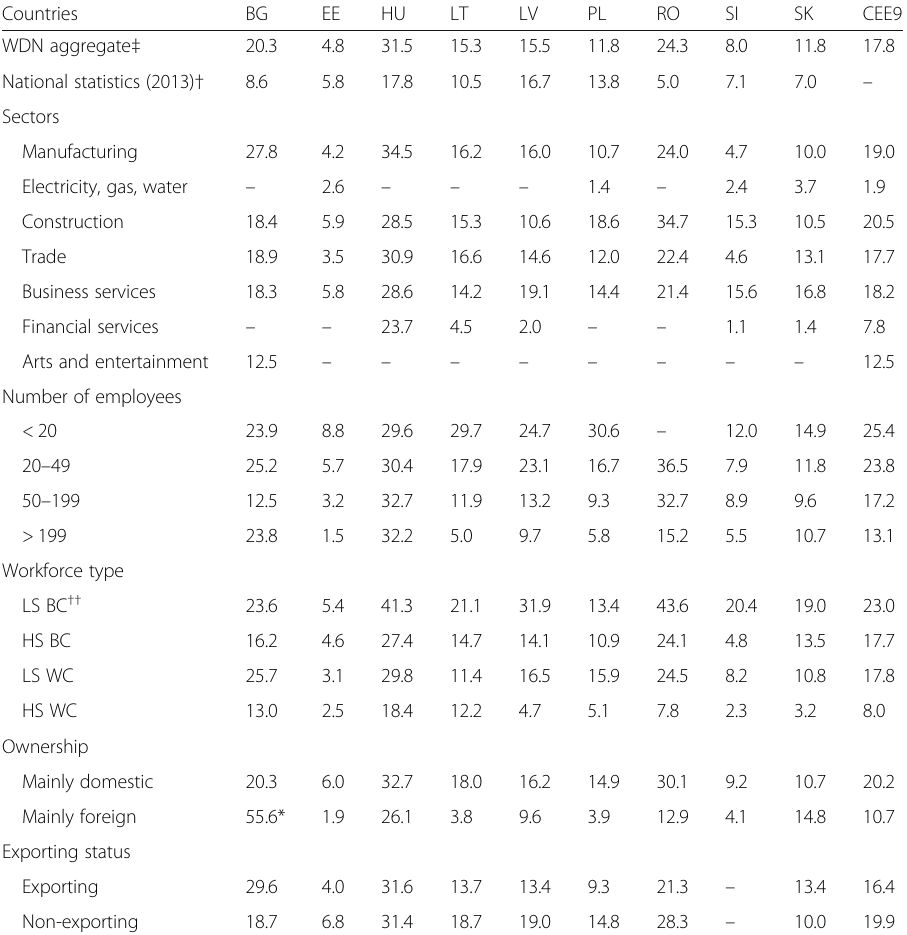
Table 2 Average share of employees of firms earning the minimum wage (%) Countries BG